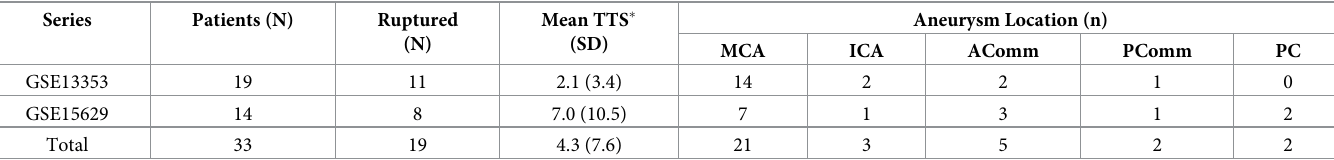
Table 1. Summary of study